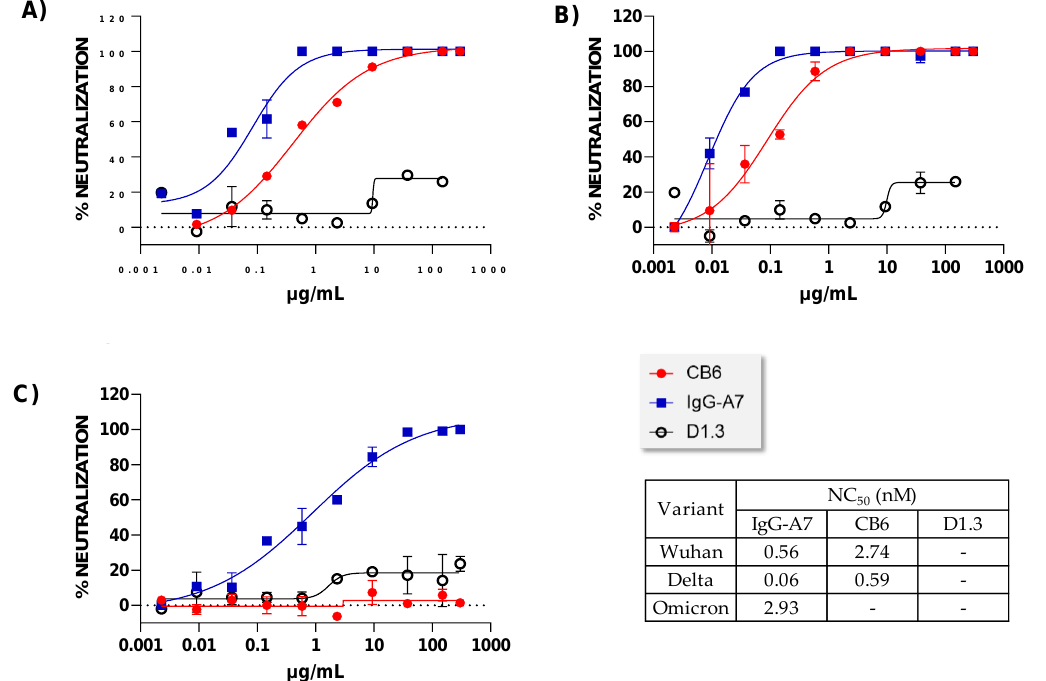
Figure 4. Dose-response neutralization curves of IgG-A7, CB6 and D1.3 (negative control) in PRNT for different variants of SARS-CoV-2. ( A ) WT, ( B ) Delta, and ( C ) Omicron. The Table on the left-bottom corner reports the NC 50 values obtained by fitting the raw data to a four-parameter dose-response curve in GraphPad Prism 9.3.1.